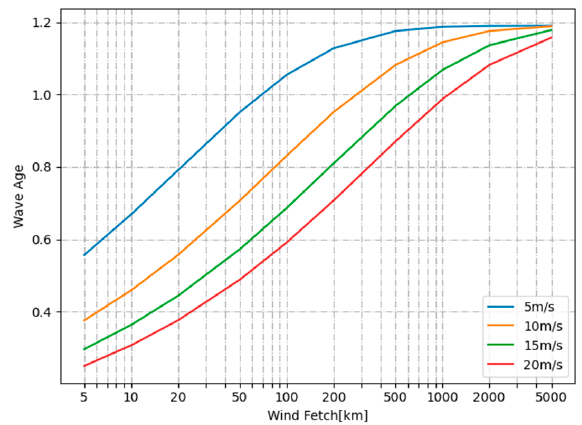
17 of 28 Figure 14. Variation in U WD and standard deviation with radar azimuth for 5, 10, and 15 m/s wind speeds corresponding to different wind fetches (50 km, 100 km, and 500 km), with radar incidence angles of 6° and 12°, wind direction of 0°, and no swell. The y-axis on the left refers to U WD values, which are shown in colored solid lines. The y-axis on the right refers to U WD standard deviations, which are shown in colored dashed lines. For the Elfouhaily spectrum, inverse wave age 𝛺 (cid:3030) can be expressed as a function of wind fetch: 𝛺 (cid:3030) = 0.84 tanh{(𝑋 𝑋 (cid:2868) ⁄ ) (cid:2868).(cid:2872) } (cid:2879)(cid:2868).(cid:2875)(cid:2873) (15) where 𝑋 (cid:2868) = 2.2 × 10 (cid:2872) , 𝑋 = 𝑘 (cid:2868) × 𝐿 (cid:3033)(cid:3032)(cid:3047)(cid:3030)(cid:3035) , 𝑘 (cid:2868) = 𝑔 𝑈 (cid:2869)(cid:2868)(cid:2870) ⁄